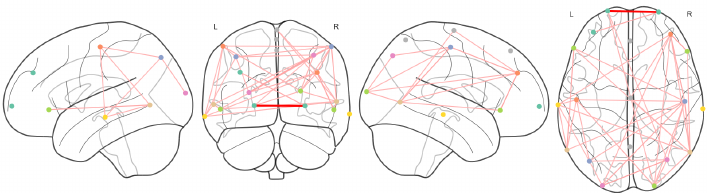
Figure 3. Network representation for CG group, including nodes, connections and their strength in alpha frequency band.